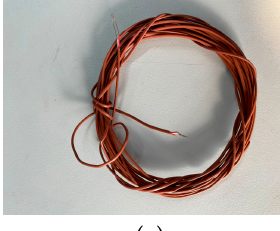
5 of 22 Figure 2. Layout of the measurement points. Table 1. Details of the measurement instruments.